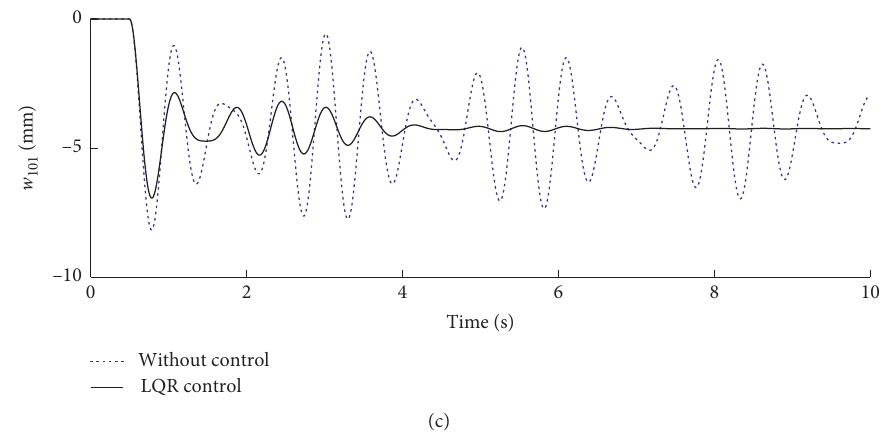
Figure 9: Response of the controlled system with step excitation.